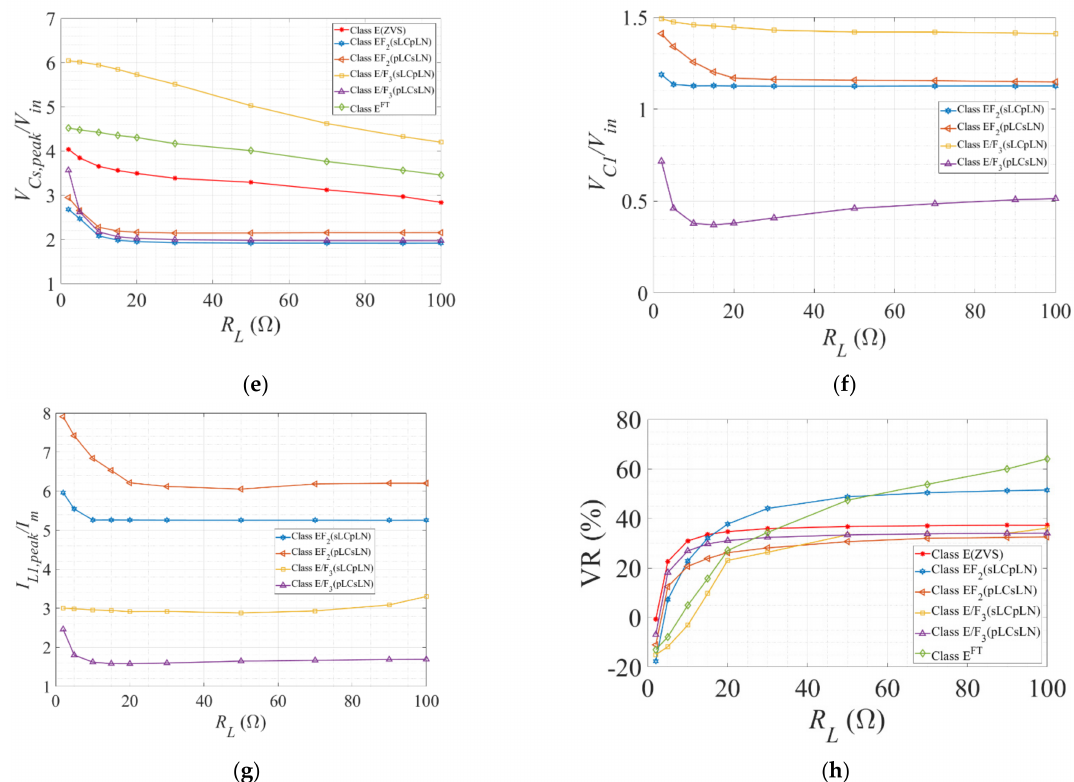
Figure 10. ( a ) The power output capability ( c p ); ( b ) efficiency ( η ); ( c ) the normalized peak switch voltage ( V S 1 ,peak / V in ); ( d ) the normalized peak switch current ( I S 1 ,peak / I m ); ( e ) the normalized peak resonant capacitor voltage ( V cs,peak / V in ); ( f ) the normalized peak auxiliary resonant capacitor voltage ( V C 1 ,peak / V in ); ( g ) the normalized peak auxiliary resonant current ( I L 1 ,peak / I m ); ( h ) the voltage regulation (VR) in percentage against load resistance ( R L ) at f s = 220 kHz, D = 0.50 or 0.40, k ≈ 0.30 (EF 2 ) and 0.67 (E/F 3